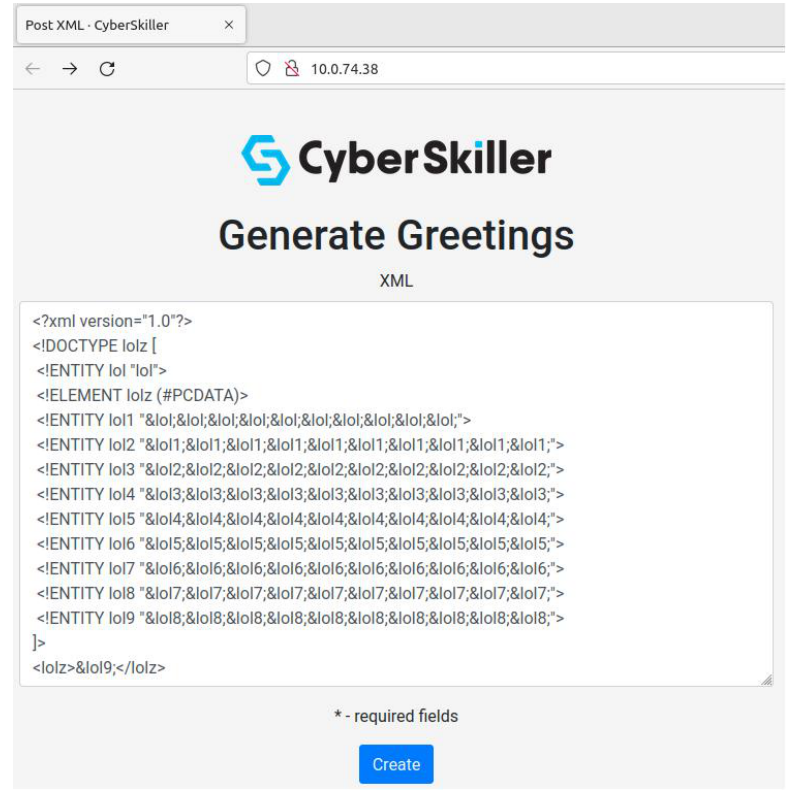
Figure 6. Exercise 7.2: Denial-of-Service Attack with the Use of an XML Bomb (⋆)